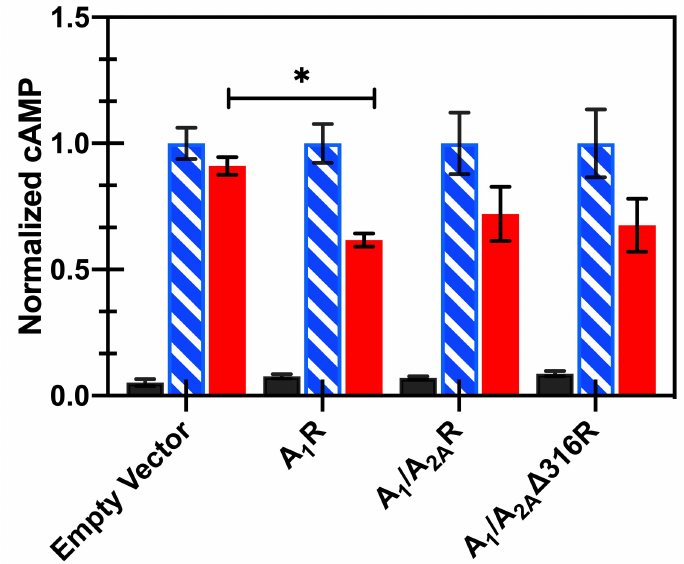
Figure 4. Expression of A 1 R or A 1 / A 2A R chimeras in HEK-293 cells results in inhibition of cAMP production after forskolin stimulation. Inhibition of cAMP production with A 1 R and compared to pCEP (empty) vector controls and A 1 / A 2A R and A 1 / A 2A ∆ 316R chimeras (no ligand in black filled bars, 10 µ M forskolin in blue hatched bars, 10 µ M forskolin and 1 µ M CPA in red filled bars). Data represent the mean ± S.E.M. for three independent transfections performed in triplicate (* p < 0.001, Student’s t